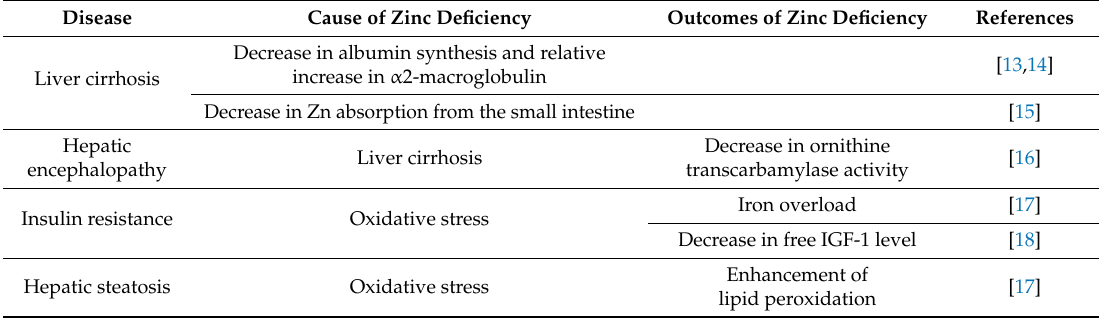
Table 1. Metabolic abnormalities causing zinc deficiency and metabolic abnormalities deriving from zinc